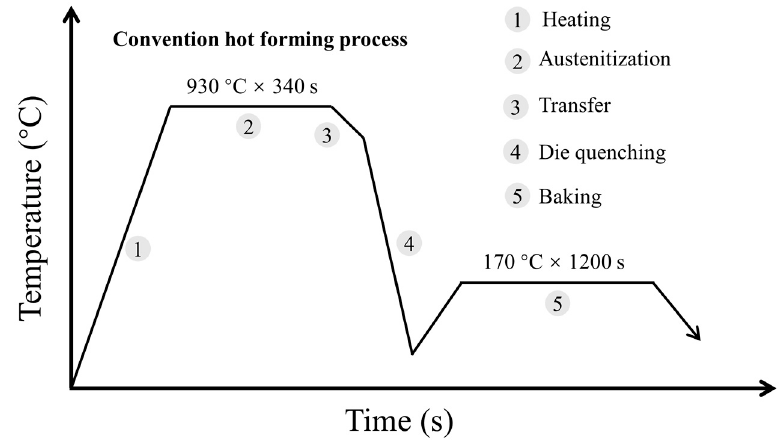
Figure 2 . Schematic diagram of the hot forming process. Figure 2. Schematic diagram of the hot forming